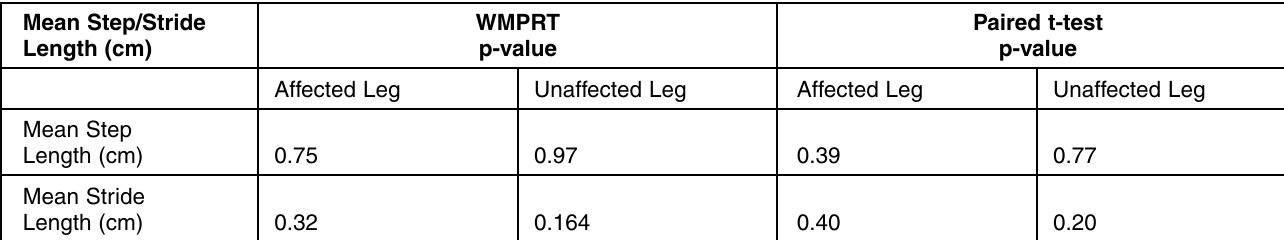
Table 4: p-values of WMPRT and Student’s paired t-test of Affected and Unaffected Leg Mean